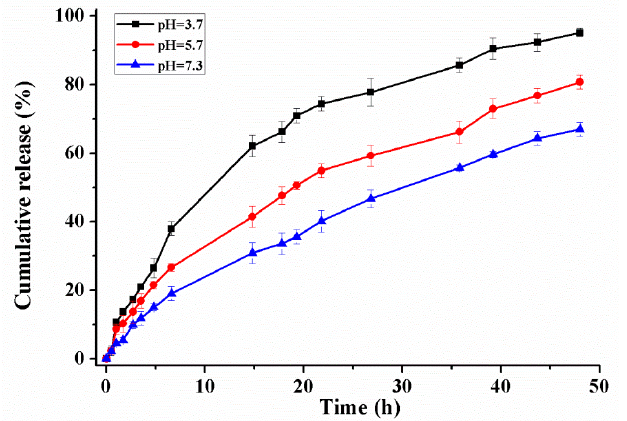
Figure 8. Pyraclostrobin released at different pH value. Error bars correspond to standard errors of triplicate measurements.